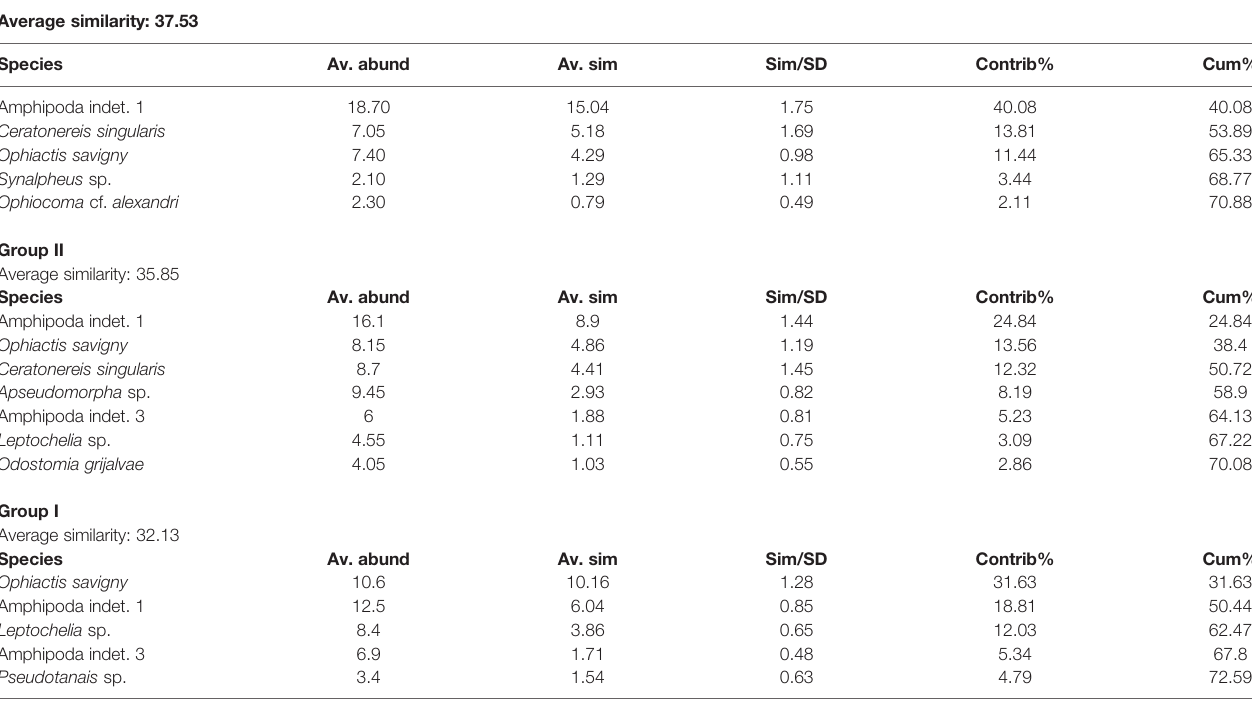
TABLE 7 | Results of the SIMPER analysis for within-group